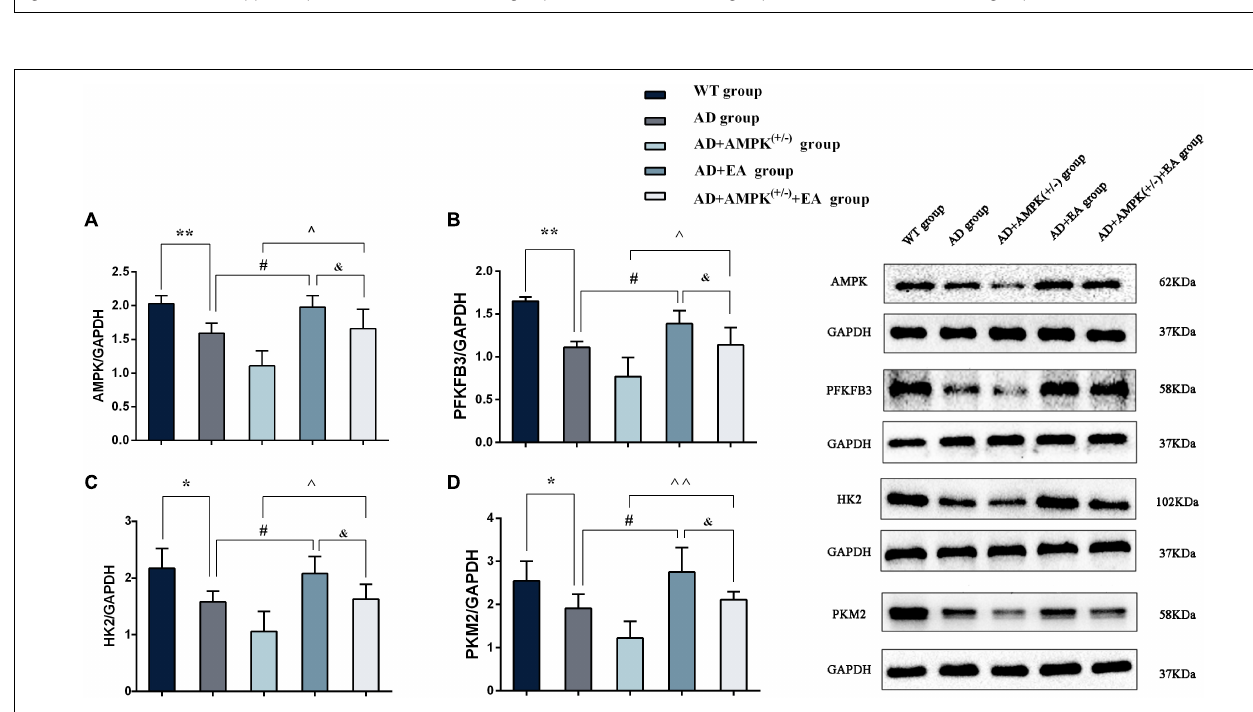
FIGURE 5 | Electroacupuncture intervention could promote the expression of aerobic glycolysis (AG)-related proteins. (A–D) The expression of AMPK, 2,6-fructose-biphosphatase 3 (PFKFB3), hexokinase II (HK2), and pyruvate kinase M2 (PKM2) in the hippocampus of five groups after EA intervention; (E) representative protein images of each AG-related protein in different groups. * P < 0.05, ** P < 0.01 vs. the WT group; # P < 0.05 vs. the AD group; ∧ P < 0.05; ∧∧ P < 0.01 vs. the AD + AMPK ( + / – ) group; & P < 0.05 vs. the AD + EA group.